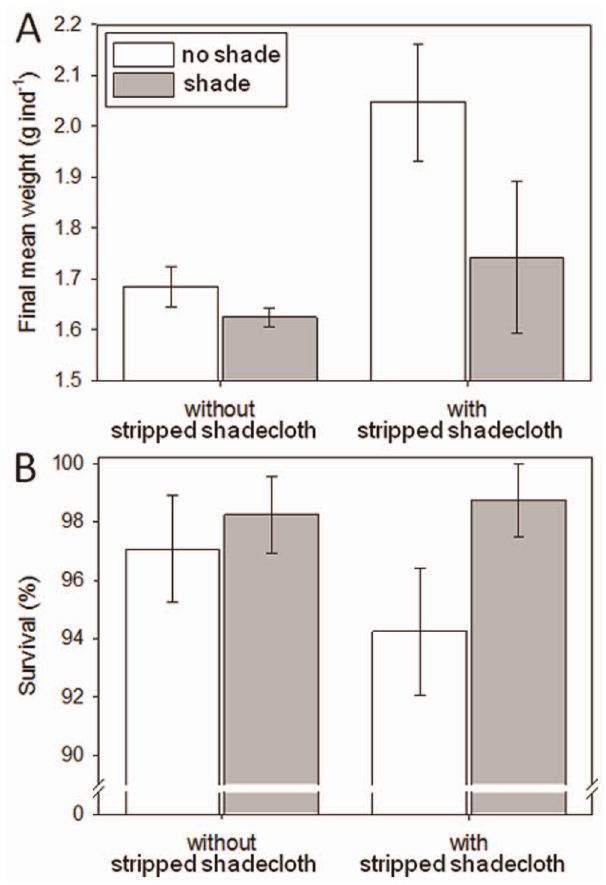
Figure 5. Effects of increasing mesh surfaces and shading. Bar graphs of (A) average individual body weights and (B) average survival of sandfish in fine-mesh enclosures with and without stripped shadecloth, and with (shaded) and without (open) shade; n =6. Error bars are 1 standard error of the mean.